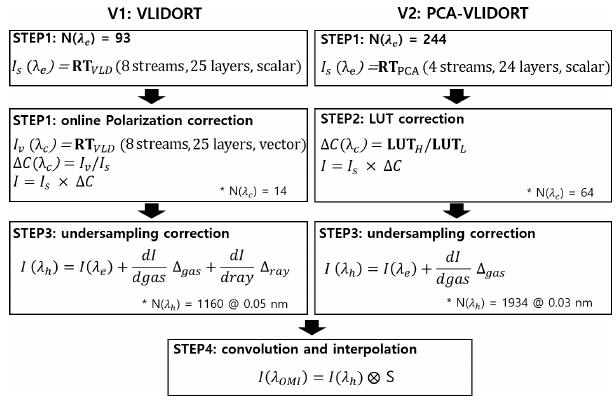
Figure 1. Schematic flowcharts of VLIDORT (v1) and PCA- VLIDORT (v2) based forward models, respectively. Note that VLI- DORT was used in the generation of the OMPROFOZ v1 dataset, while PCA-VLIDORT is in preparation for OMPROFOZ v2 pro- duction. The number of wavelengths used in each process is denoted as N(λ) when the spectral window 270–330nm is applied. λ e repre- sents the wavelength grids used for RT calculation, while λ c and λ h are grids used in RT approximation correction and undersampling correction, respectively. See text for definition of other